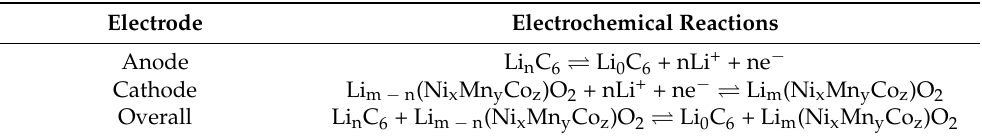
Table 2. Electrochemical reactions of a lithium nickel manganese cobalt oxide (NMC)